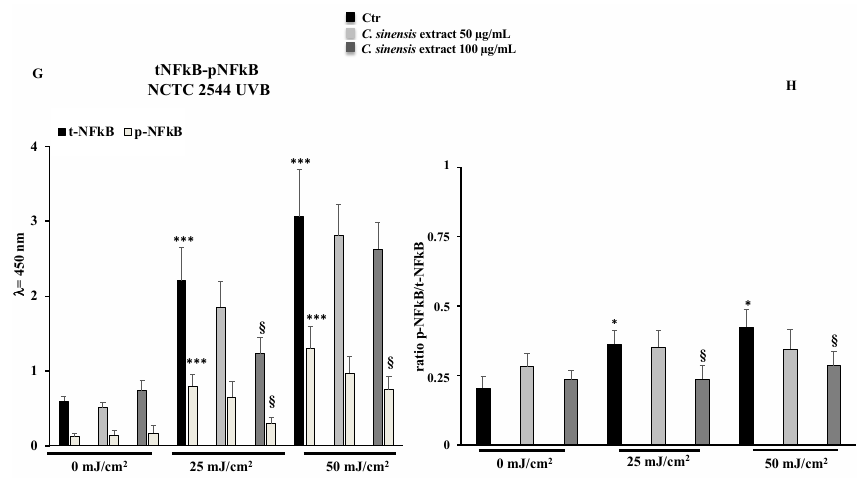
Figure 10. Effects of C. sinensis extract pretreatment (25 and 50 µ g/mL) for 4 h on the release of TNF- alpha ( A , B ), IL-6 ( C , D ) and the activation of NFkB ( E – H ) after exposure to UVB (25 and 50 mJ/cm 2 ) in HFF1 and NCT 2544 cells, respectively. The data are reported as the mean ± S.D. from triplicate experiments. * Significant vs. untreated control cells: p < 0.05; *** Significant vs. untreated control cells: p < 0.001; # Significant vs. untreated irradiated cells: p < 0.05; ## Significant vs. untreated irradiated cells: p < 0.01; § Significant vs. treated irradiated p ≤ 0.05.